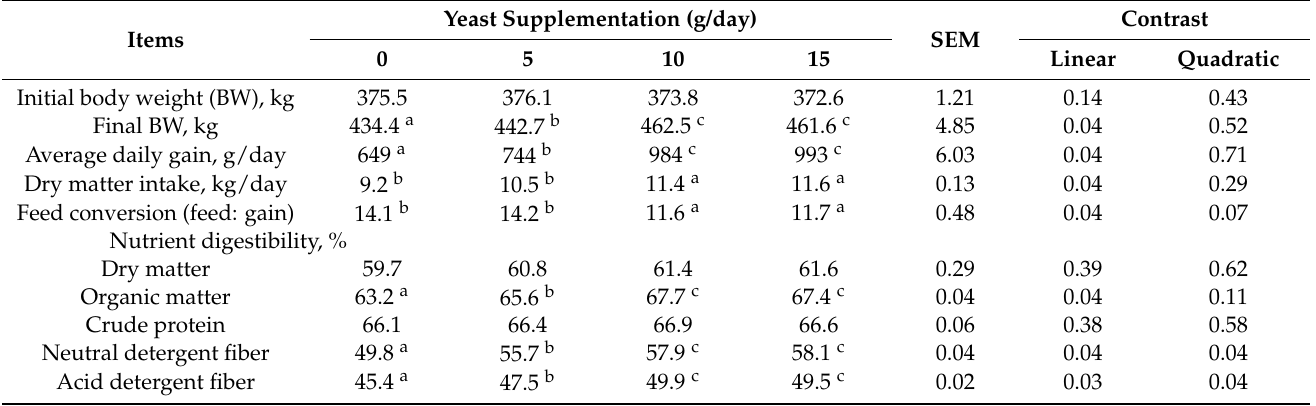
Table 3. Effect of yeast supplementation in high concentrate diet on average daily gain, dietary dry matter intake, feed conversion ratio, and nutrient digestibility in fattening steers.